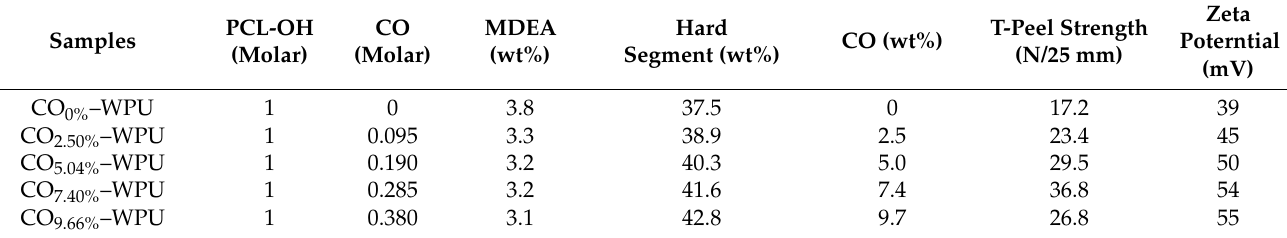
Table 1. Feeding composition and properties of WPUs